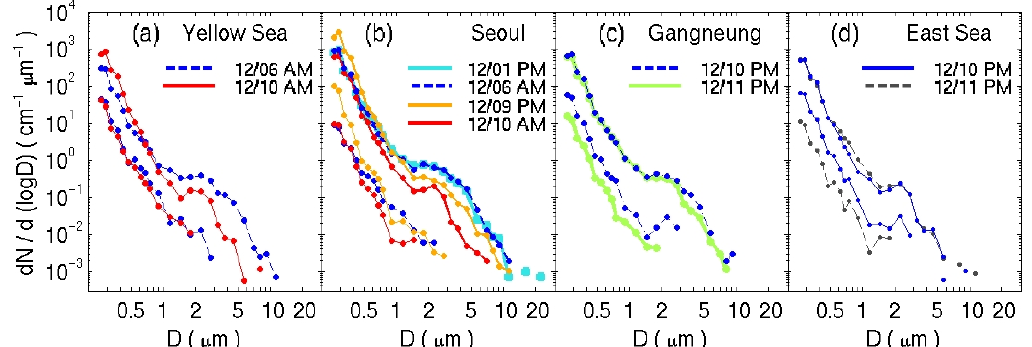
Figure 5. Particle size distributions (PSD) obtained from the ( a ) Yellow Sea, ( b ) Seoul, ( c ) Gangneung and ( d ) East Sea. Individual lines represent PSDs calculated from level-leg flights within and above the PBL. For example, PSDs on 6 December within and above PBL were obtained from 661 m and 1903 m, respectively.